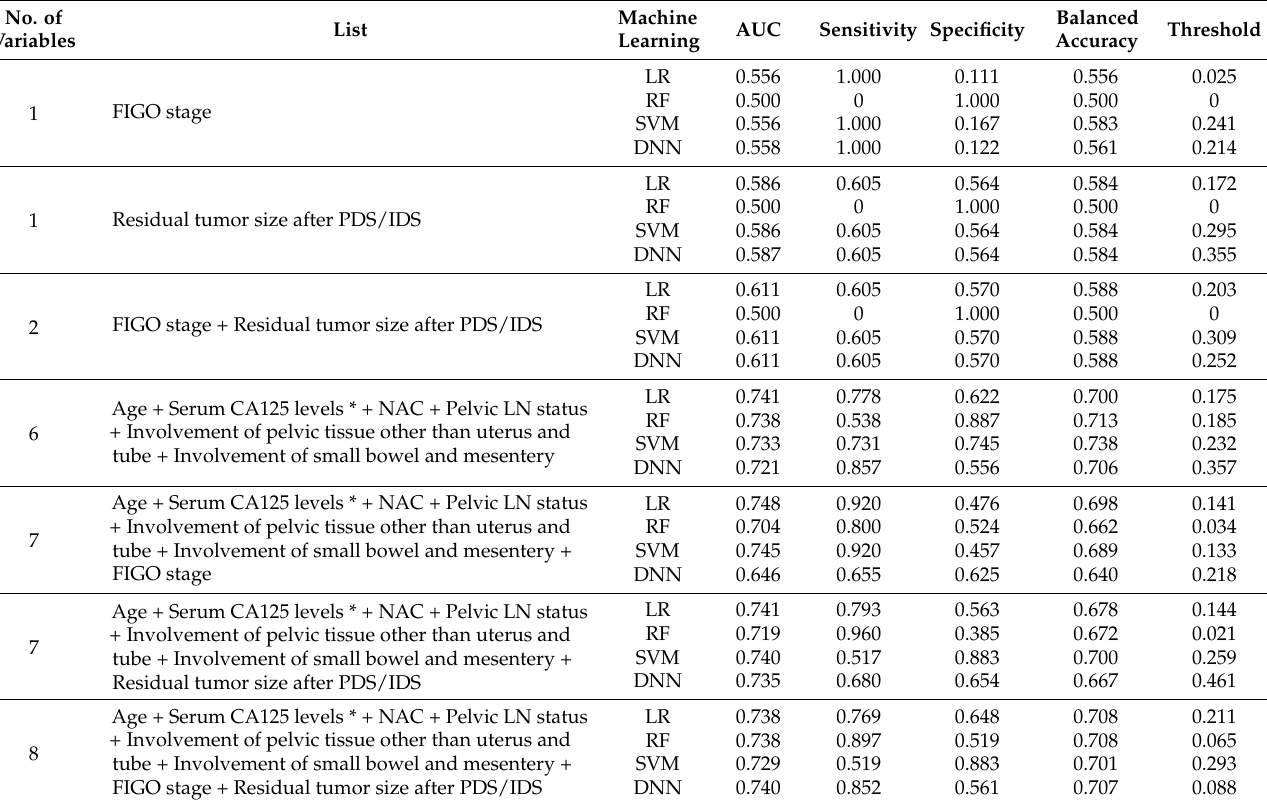
Table 2. Performance of developed models identifying platinum-resistant